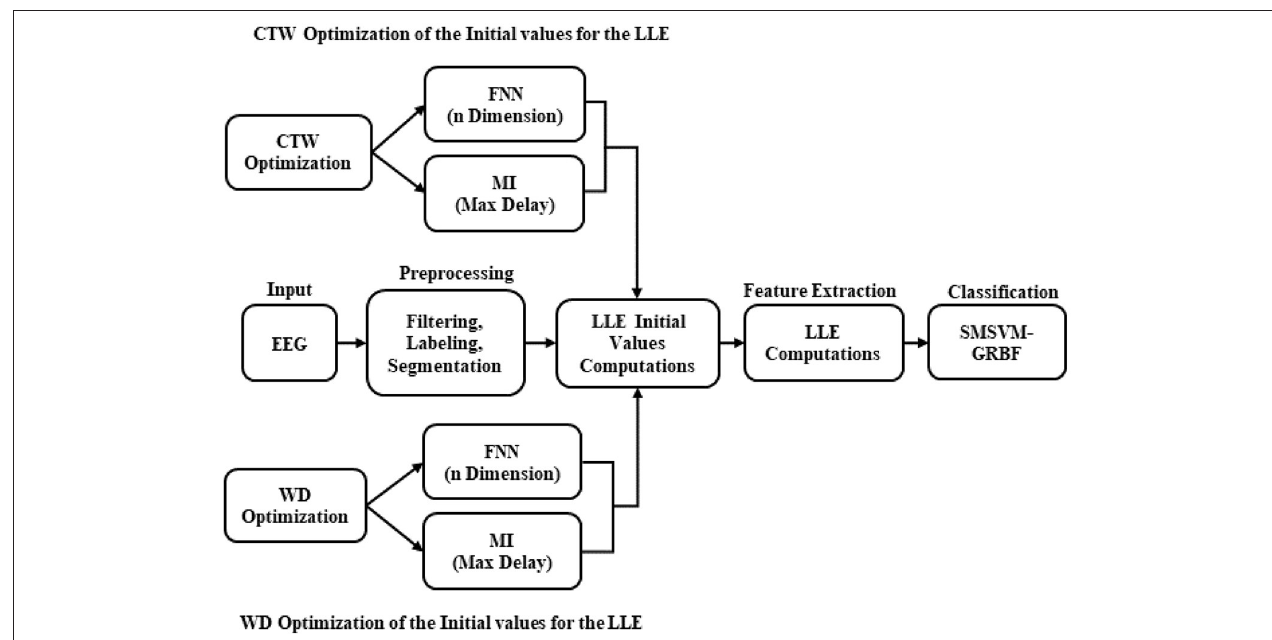
FIGURE 2 | The algorithm schematic for identifying the ERD/ERS